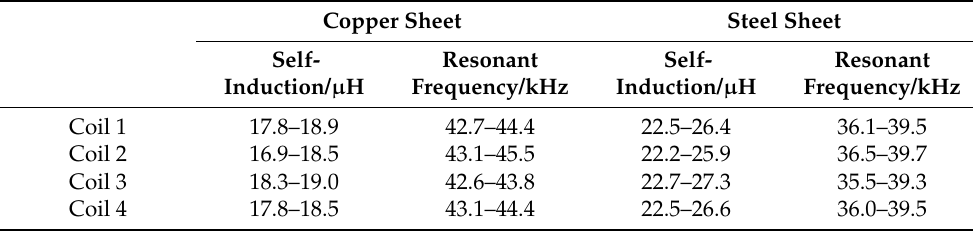
Table 7. The offset of self-inductance and resonance frequency.